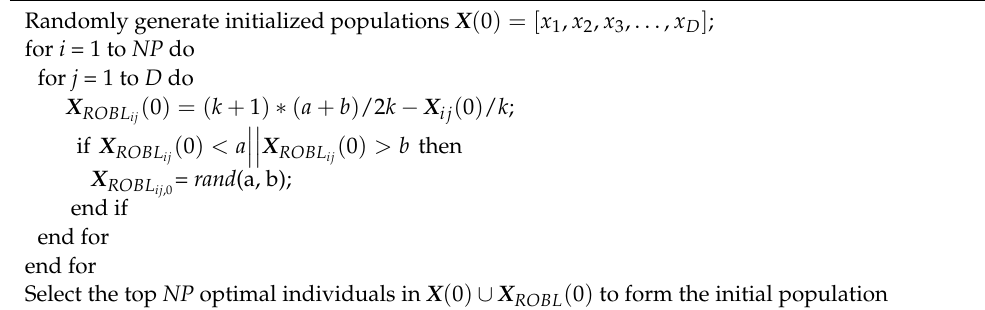
Algorithm 1 . Refractive opposition-based learning population